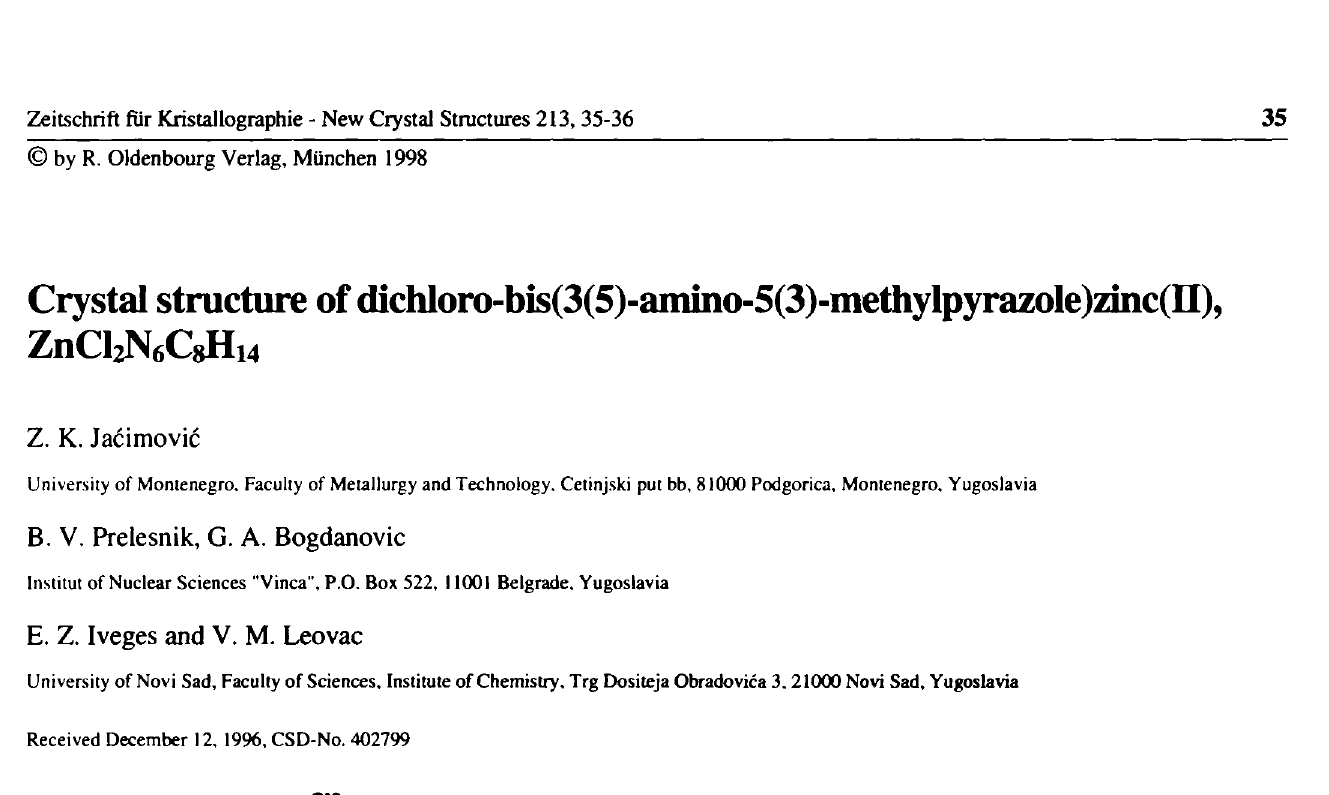
Table 1. Parameters used for the X-ray data collection